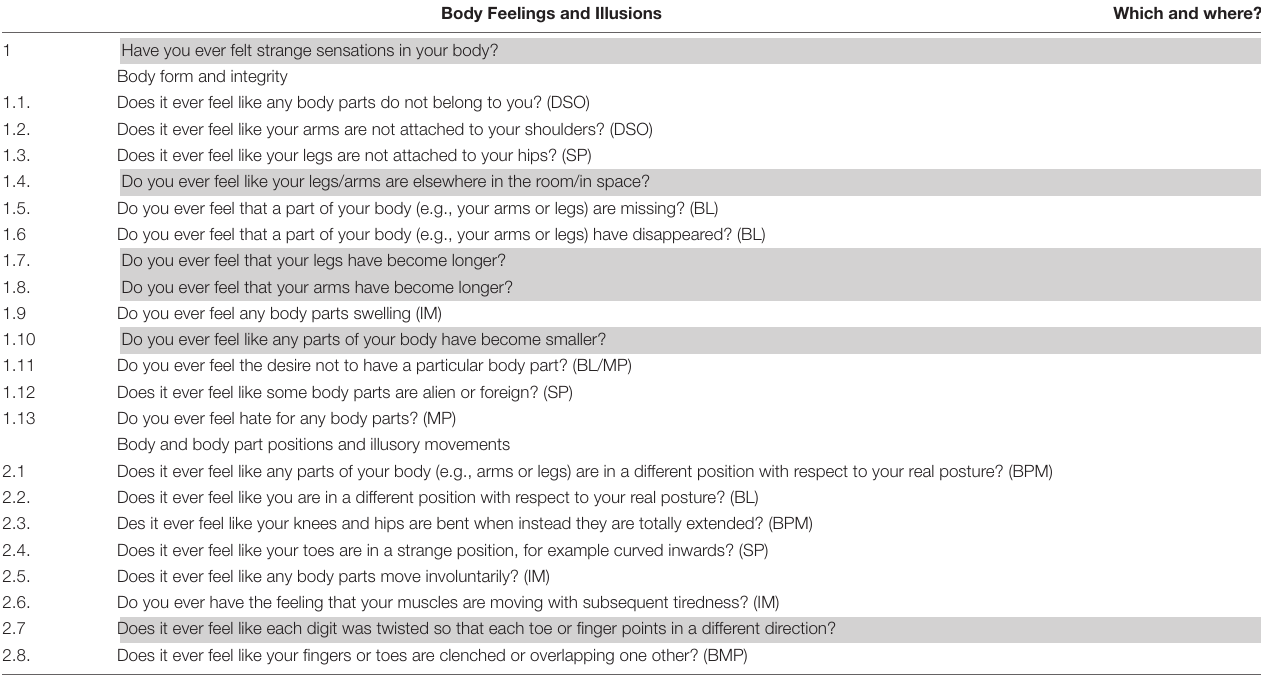
TABLE 2 | The body feelings and illusions questionnaire. Body Feelings and Illusions Which and